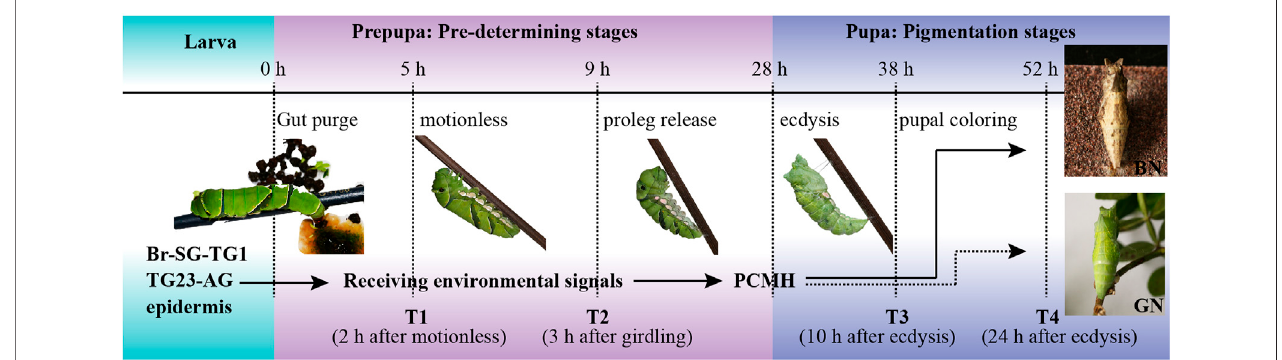
FIGURE 1 | Developmental process of dimorphic pupal color formation in Papilio xuthus . The brain of pre-pupa receives and integrates carefully environmental factors frompupationsiteduringthepre-determiningstagesbytactilesignals,andsynthesizesandreleasesahormonecalledpupacuticlemelanizinghormone(PCMH) from brain-suboesophageal ganglion and prothoracic ganglion complexes (Br-SG-TG1). This hormone determines the color of the pupal body in pigmentation stages. BN, brown pupae; GN, green pupae; TG23-AG, the mesothoracic and metathoracic ganglia (TG23) and all abdominal ganglia (AG) complexes. The solid arrow indicatesPCMHrelease,and thedotted arrowindicatesnoPCMHrelease. Samplesinthisstudy werecollectedfromfour timepoints, includingT1(pre-pupae,2 hafter gutpurge)andT2(prolegrelease,3 hafterformingthegarteraroundthebody)inpre-determiningstages,T3(pupalcoloring,10 hafterecdysis)andT4(pupalcoloration, 24 h after ecdysis) in pigmentation